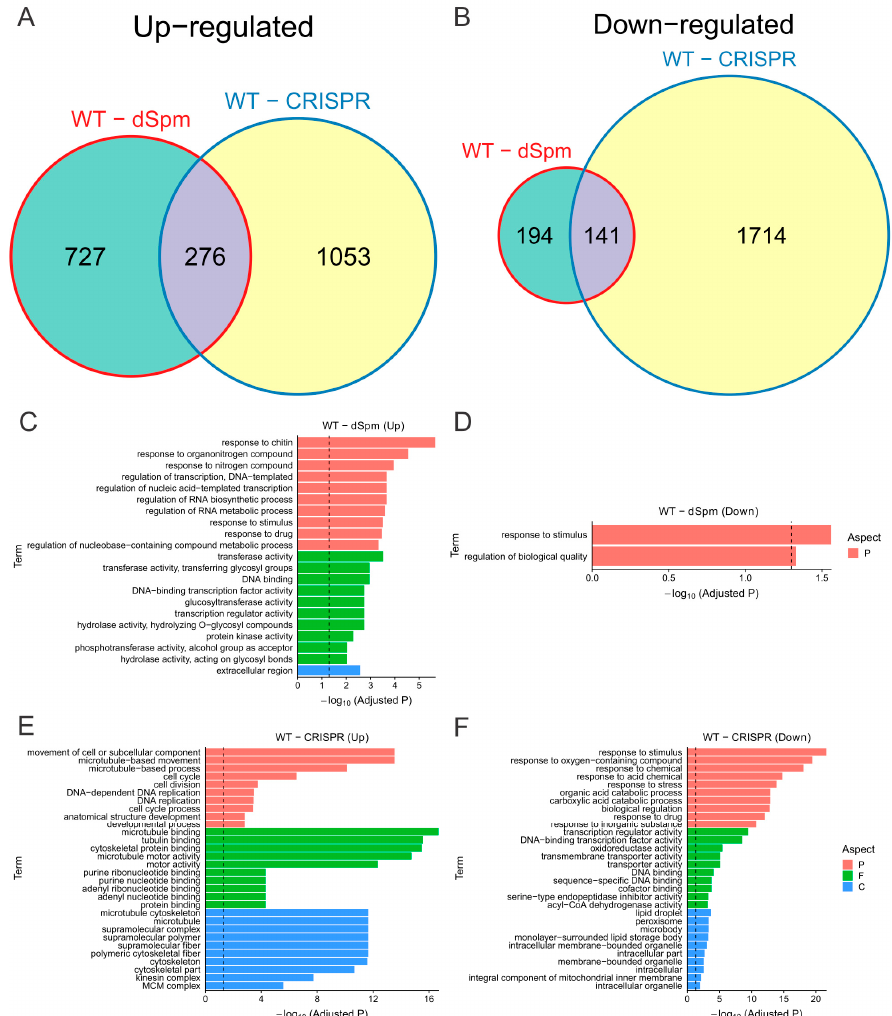
Figure 6. Comparison of gene expression changes during OsMADS58 expression perturbation. ( A , B ) Venn plots of differentially expressed genes (between wild type vs. osmads58 dSpm and wild type vs. osmads58 CRISPR). The upregulated ( A ) and downregulated ( B ) genes were used for comparison, respectively. The circle sizes denote the numbers of differentially expressed genes in the corresponding gene sets. ( C – F ) Enriched Gene Ontology (GO) terms for each set of differentially expressed genes. Colors denote the aspects of GO terms (P: biological process, F: molecular function, C: cellular component). Only the top 10 enriched terms are shown (Fisher’s exact test, P values adjusted by FDR).